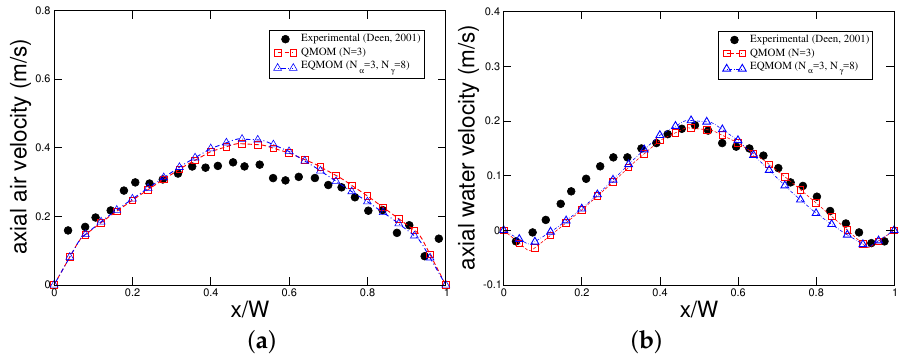
Figure 6. Comparison between EQMOM and QMOM against experimental data: ( a ) axial gas velocity and ( b ) axial liquid velocity for the case of Deen [64].